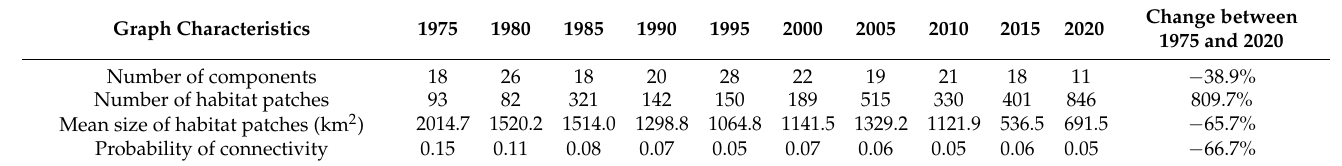
Table 2. Assessment of habitat connectivity in the Yellow River Delta between 1975 and 2020.